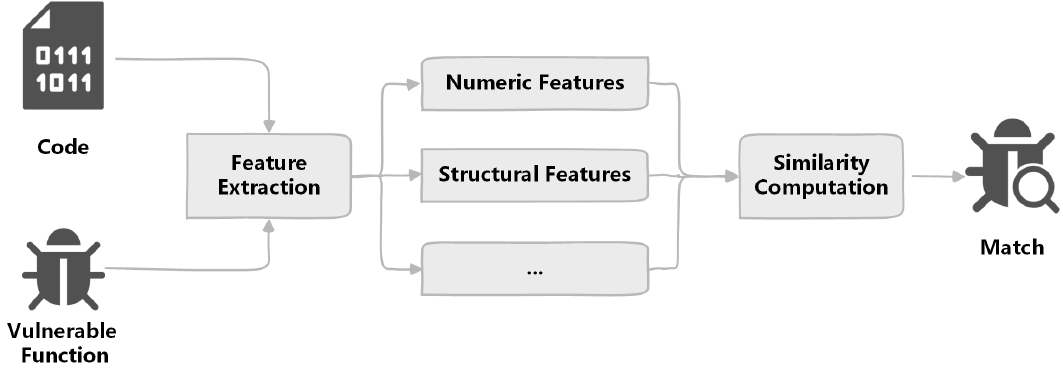
Figure 4. Similarity detection